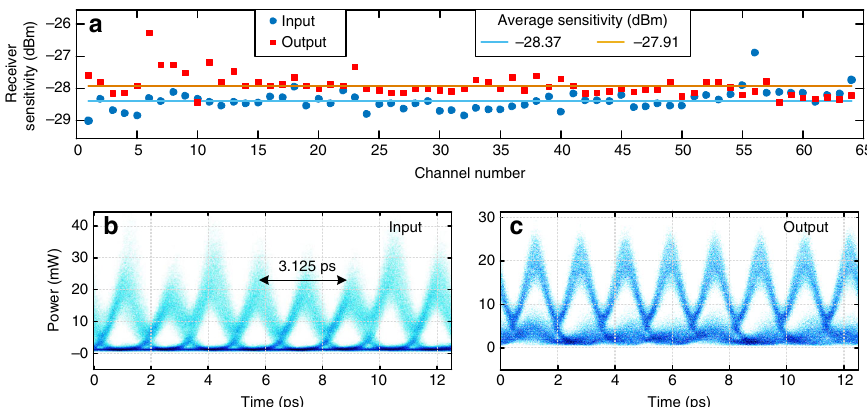
Fig. 5 Experimental results. a Receiver sensitivity, i.e., required average power at the output of the detection system to ensure a bit error rate (BER) <10 − 7 , measured for each of the 64 channels (at 10 Gbit/s) of the 640 Gbit/s OTDM input (blue) and output (red) signals. b , c Eye diagrams (overlapping the temporal signals over eight consecutive bit time periods) of the 640 Gbit/s coherent digital b input data signal and c the inverted output data